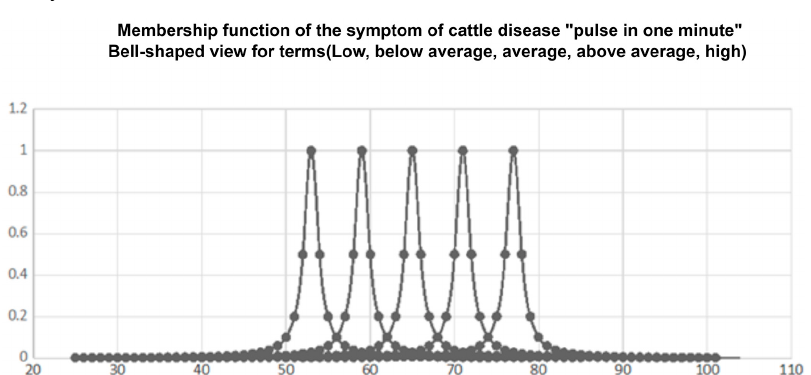
Figure 5. Membership functions of input terms after learning .